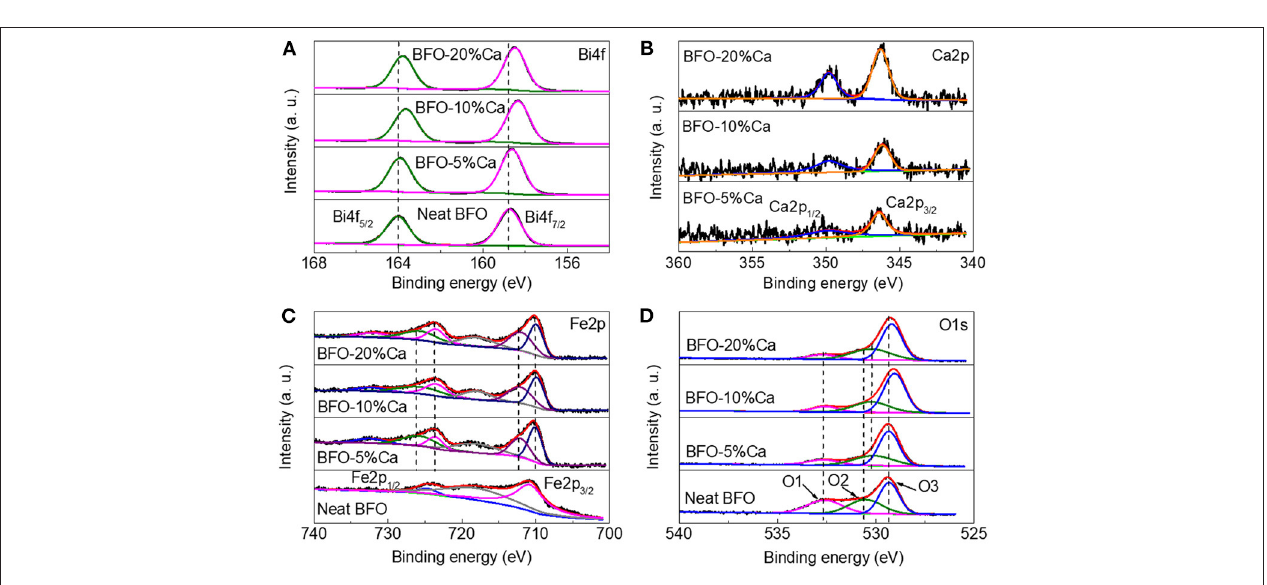
Frontiers in Materials |